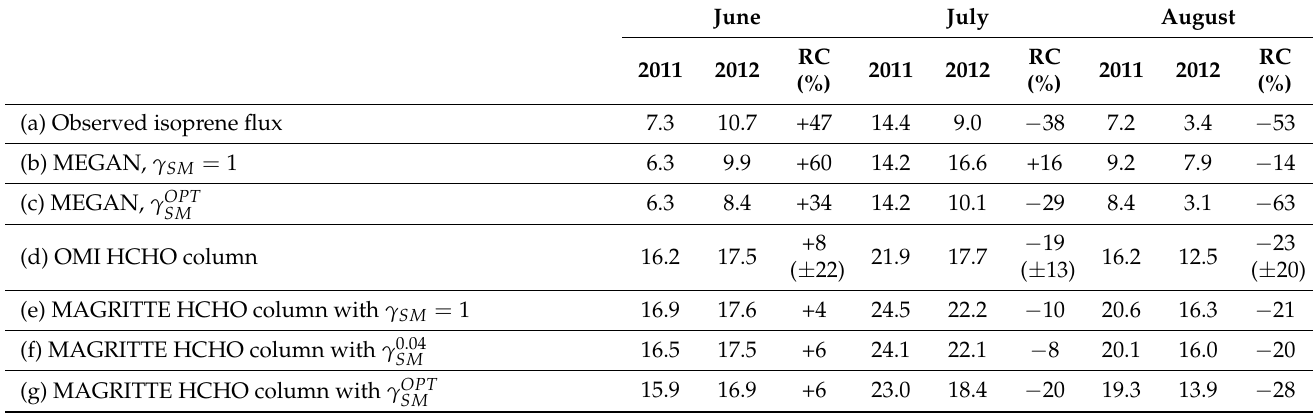
Figure 5. Biweekly averaged ( a ) observed isoprene fluxes (in mg m − 2 h − 1 ) in June-August 2011 and 2012 (with standard deviations σ of the daily variability shown as orange shading) and MEGAN estimates in no-stress conditions and with γ OPT (with σ shown as error bars); ( b ) HCHO columns SM (10 15 molecules cm − 2 ) from OMI observations within a 20-km radius of the MOFLUX site (orange) (with systematic error bars from the retrievals) and from MAGRITTE simulations using biogenic emissions neglecting (blue) or accounting for γ OPT (green). SM Table 1. Monthly averages of ( a – c ) local isoprene fluxes (in mg m − 2 h − 1 ) from observations and MEGAN estimations (MEGAN, γ SM = 1 and MEGAN, γ OPT ); ( d – g ) formaldehyde columns SM (in 10 15 molecules cm − 2 ) observed by OMI sensor around the MOFLUX site and calculated by MAGRITTE with biogenic emissions in no-stress conditions (MAGRITTE, γ SM = 1) and applying the drought stress factor (MAGRITTE, γ 0.04 and MAGRITTE, γ OPT ). Relative changes (RC) are provided SM SM between monthly averages in years 2011 and 2012 as percentages. The relative changes in OMI columns are provided along with their uncertainty estimates at 1 σ -level calculated based on random uncertainties of columns